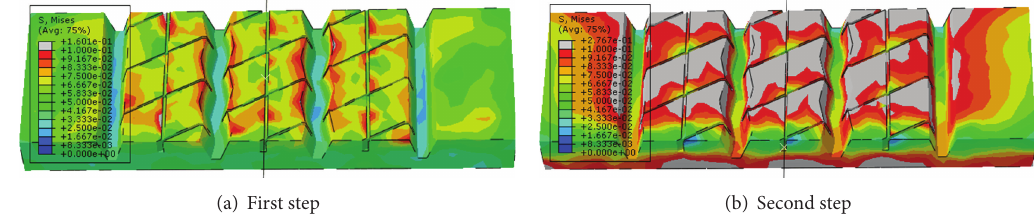
Figure 15: Distribution of von mises stress for tread block under the conditions: 𝛼 = 16 ∘ and 𝛽 = 18 ∘ .